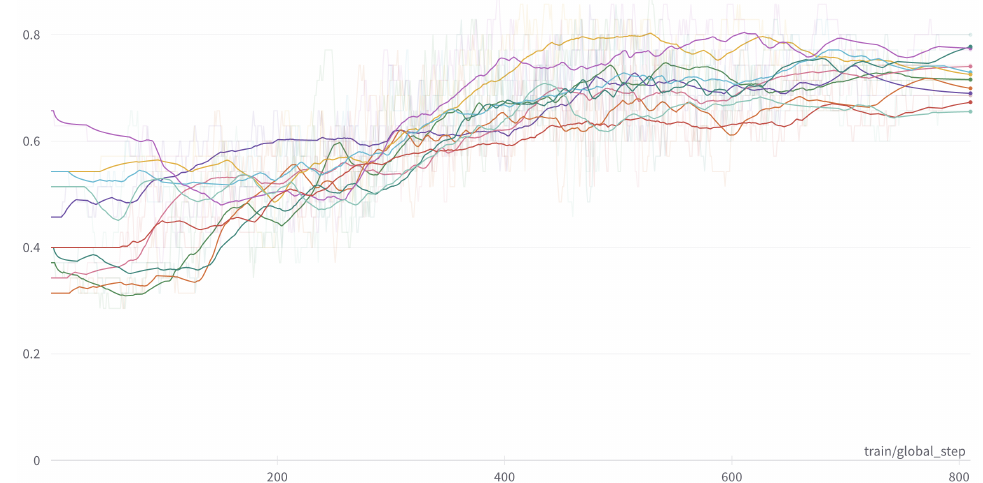
Figure 1. The accuracy on the validation dataset for the HerBERT model fine-tuned on typed utterances. Data for 10 folds.